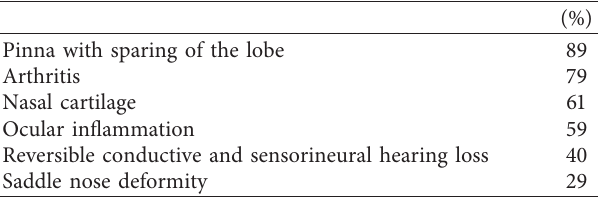
Table 1: Complications of RP by site